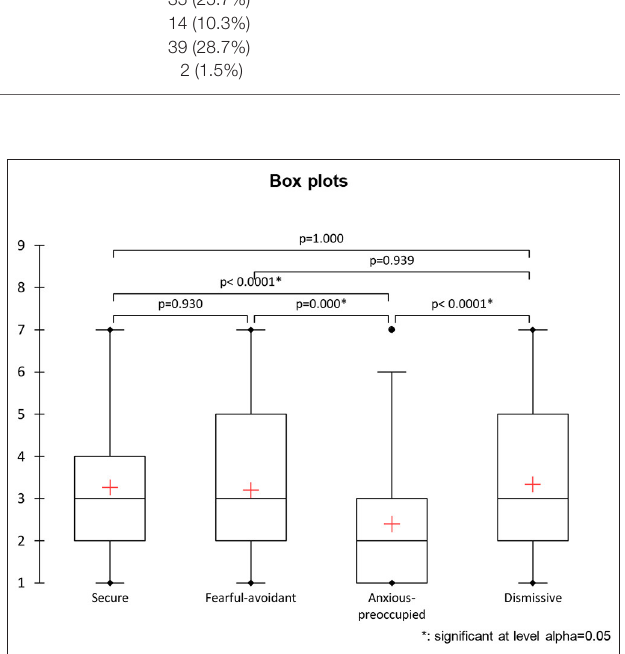
FIGURE 1 | Box plot comparisons of adult attachment style raw